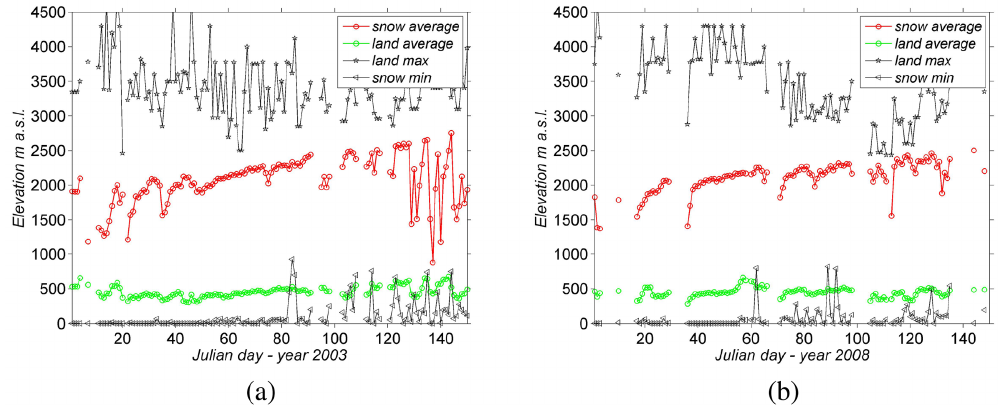
Figure 8. Regional snow and land lines from January to May in comparison with the elevations of the highest land pixel and the lowest snow pixel, year 2003 (a) and 2008 (b) . Values are provided only when output maps by step 2 are less than 50% cloud